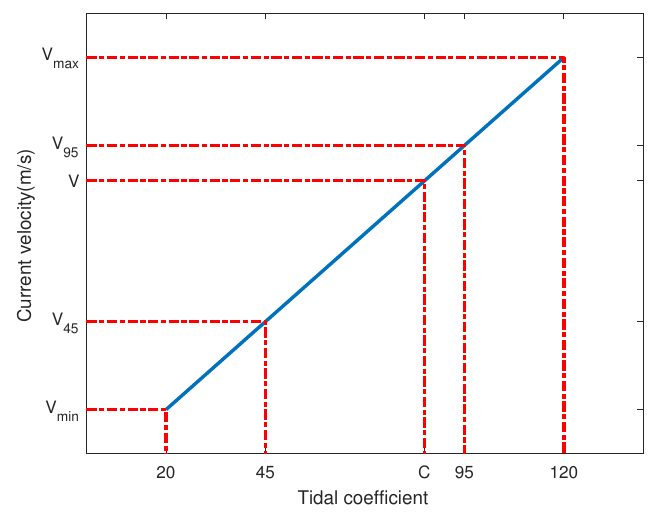
Figure 3. Linear approximation.